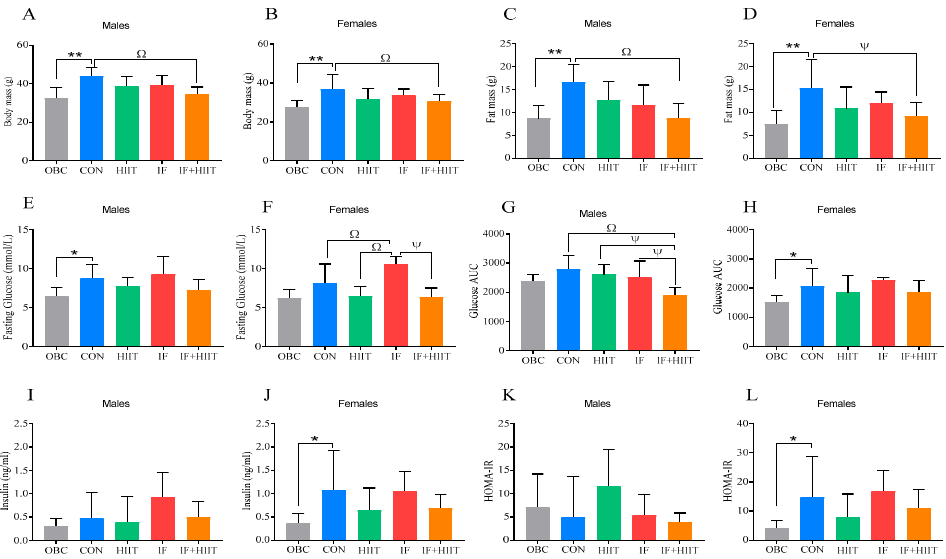
Figure 1. Body weight (g) ( AB ), fat mass (g) ( C , D ), fasting glucose (mmol/L) ( E , F ), glucose area under the curve ( G , H ), plasma insulin (ng/ml) ( I , J ) and homeostatic model assessment of insulin resistance (HOMA-IR) ( K , L ) in males and females, respectively. Bars represent the mean, and error bars (HOMA-IR) ( K , L ) in males and females, respectively. Bars represent the mean, and error bars represent the standard deviation. * and ** represent a significant difference between the OBC and the CON group at p < 0.05 and p < 0.01, respectively. Ψ and Ω represent a significant difference between the CON and IF, HIIT and IF+HIIT groups at p < 0.05 and p < 0.01, respectively.